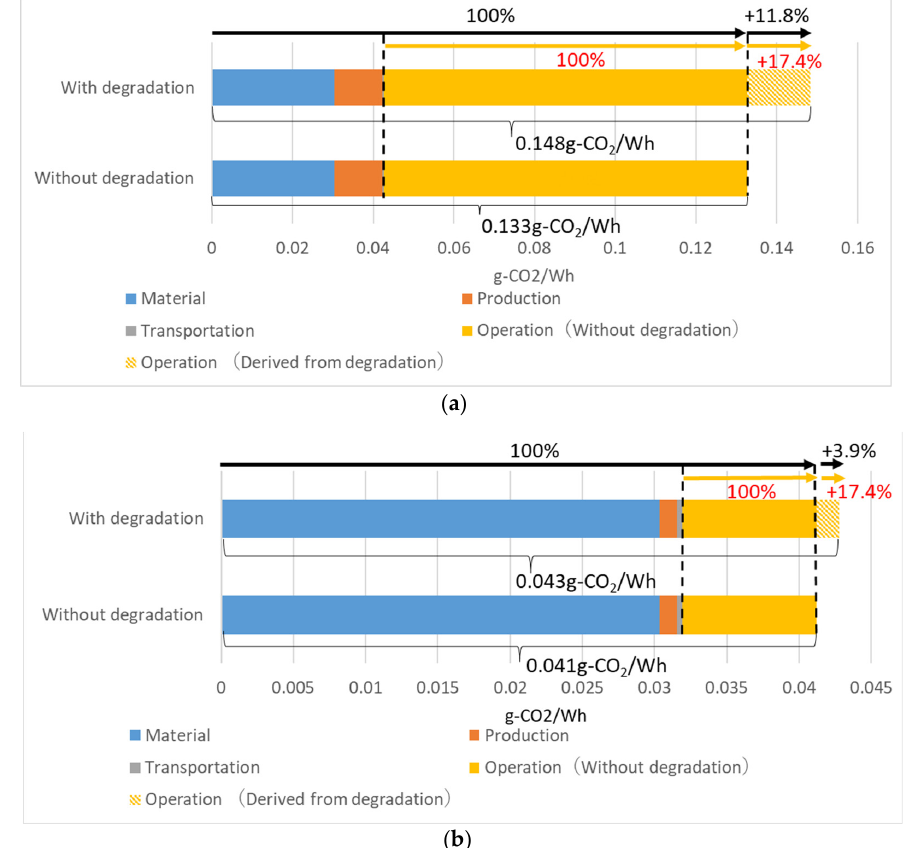
Figure 5. CO 2 emission per total lifetime delivered electricity ( a ) mix; ( b ) renewables.